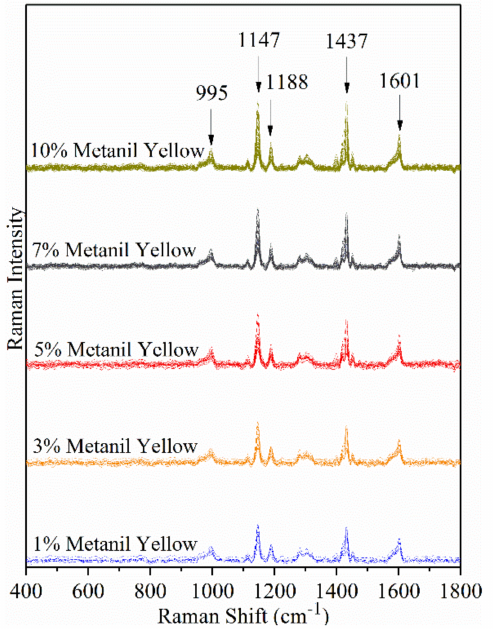
Figure 8. Raman spectra of detected metanil yellow pixels at five concentrations.